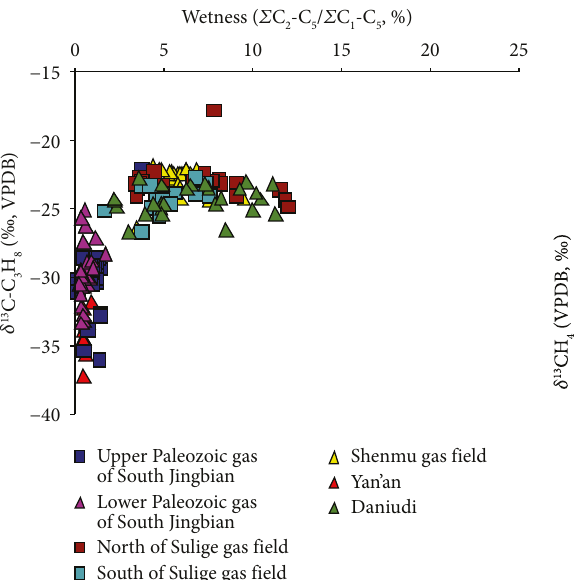
versus gas wetness with a wetness range 4